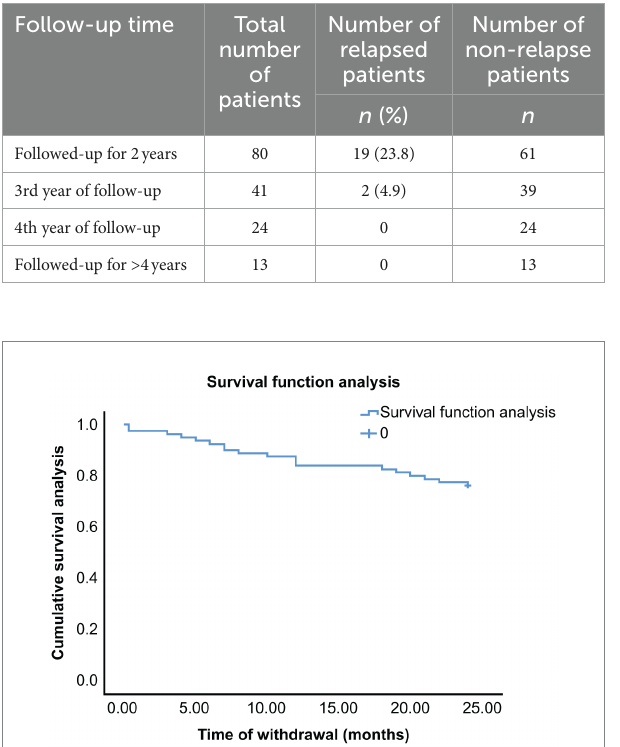
TABLE 1 Correlation between the drug withdrawal time and recurrence rate in pediatric patients with epilepsy.